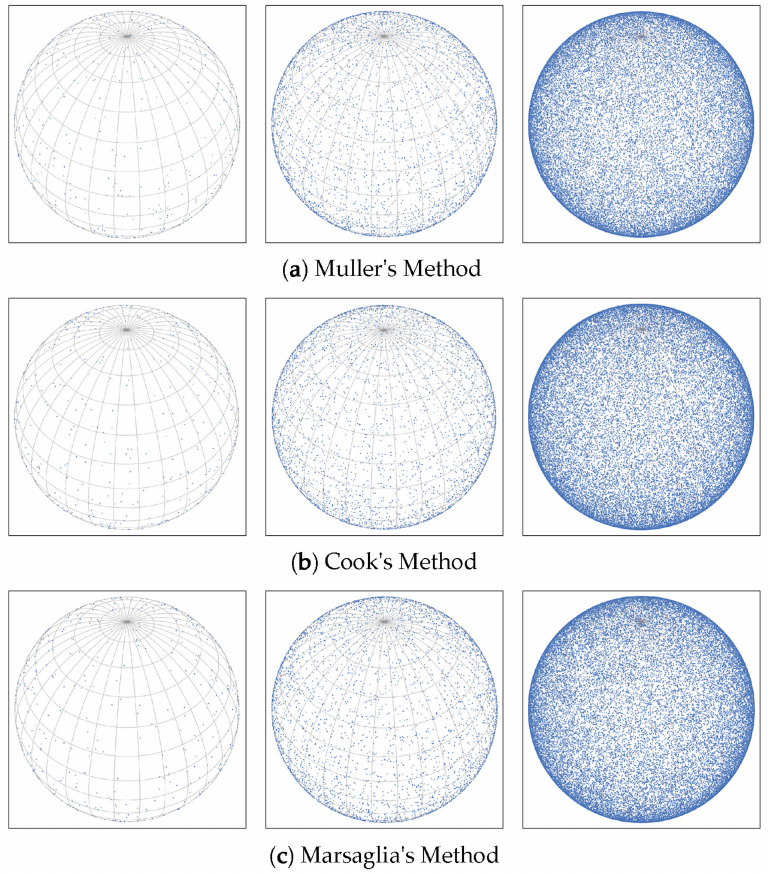
Figure 6. Distribution of points created by three algorithms. ( a ) is Muller’s, ( b ) is Cook’s and ( c ) is Marsaglia’s. The number of points from left to right is 1000, 10,000 and